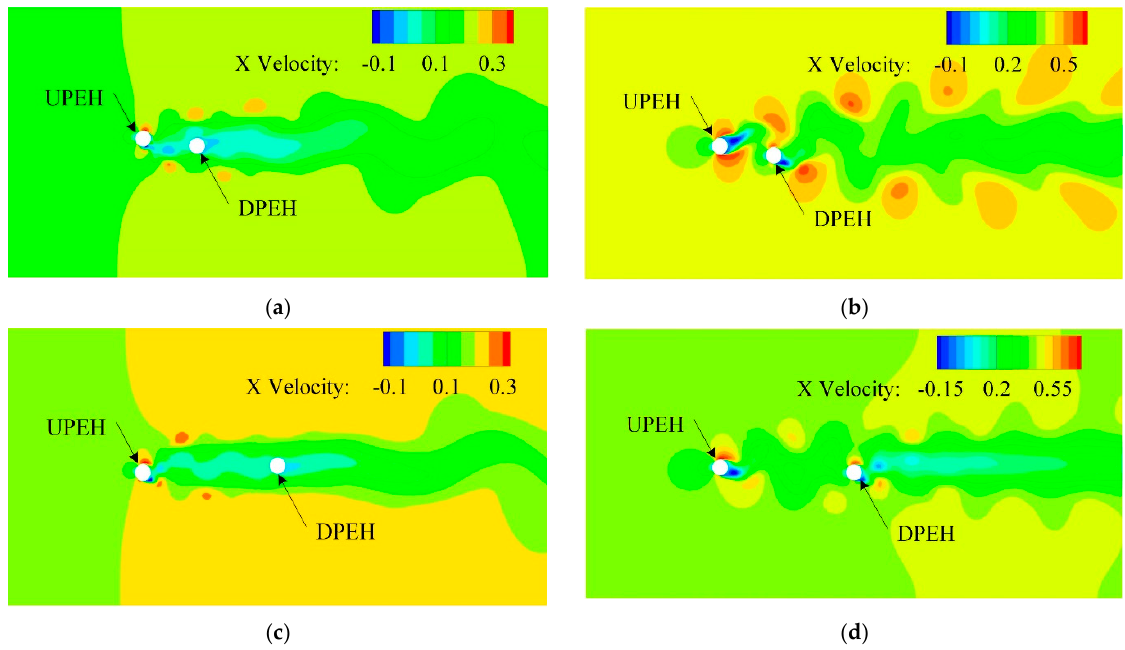
Figure 10. Flow field distribution of two tandem PEHs for various W / D and water velocities.( a ) Flow field distribution at W / D = 3.33, U = 0.19 m/s; ( b ) Flow field distribution at W / D = 3.33, U = 0.41 m/s; ( c ) Flow field distribution at W / D = 3.33, U = 0.19 m/s; ( d ) Flow field distribution at W / D = 8.33, U = 0.41 m/s.